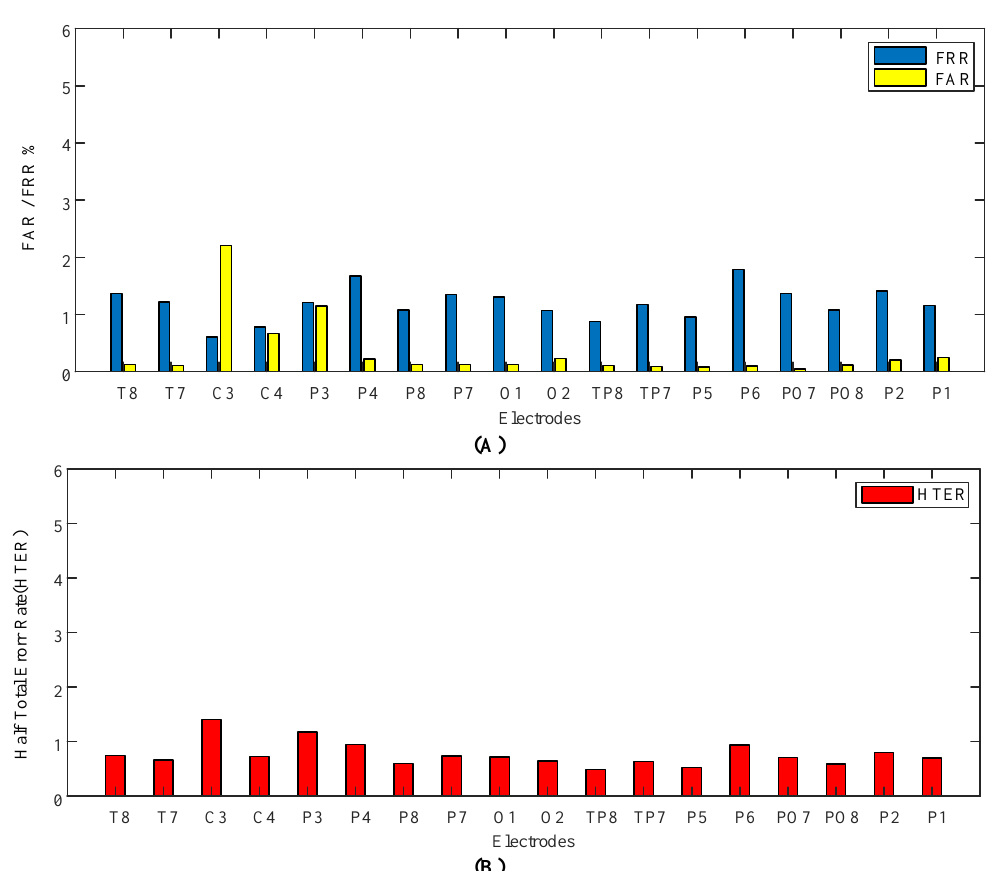
Figure 9 . The mean FAR and FRR (A), HTER (B) values for all individuals on 18 electrodes for all